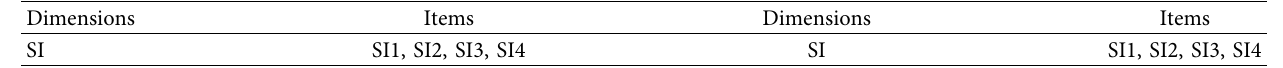
Table 2: Factor analysis of food social influence.